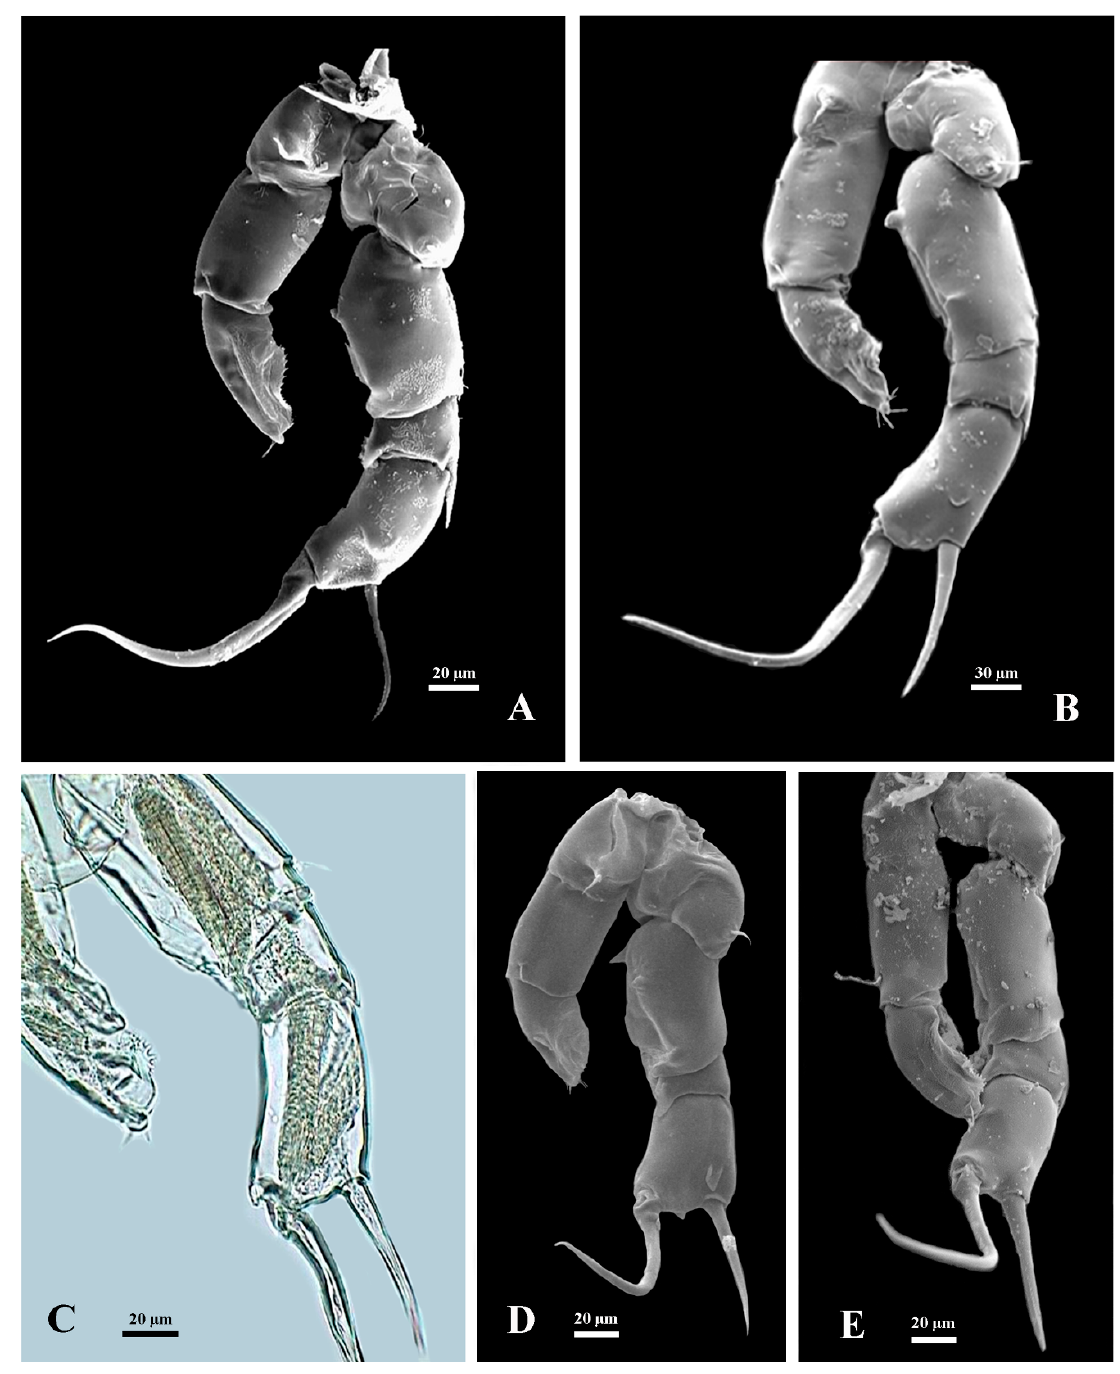
Figure 6. Photographs of the male leg 5 (P5) of four species of the genus Tropodiaptomus : ( A ) T. hebereri ; ( B ) T. oryzanus ; ( C ) T. oryzanus , showing detail of left P5; and ( D ) T. ruttneri ; ( E ) T. vicinus .